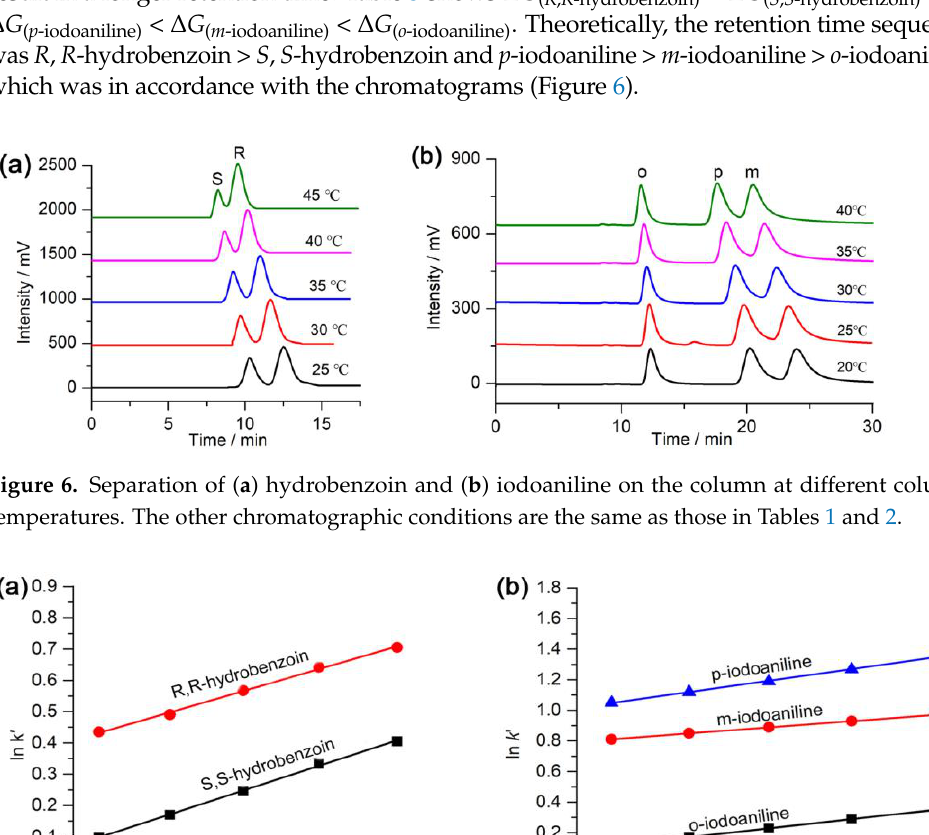
Figure 6. Separation of ( a ) hydrobenzoin and ( b ) iodoaniline on the column at different column